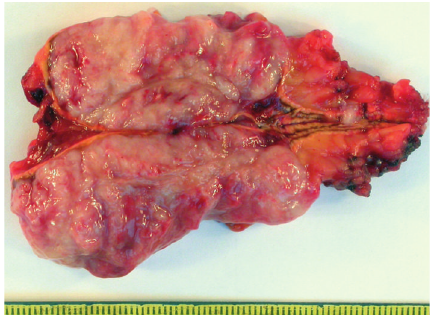
Figure 1: Macroscopic aspect of the tumor.